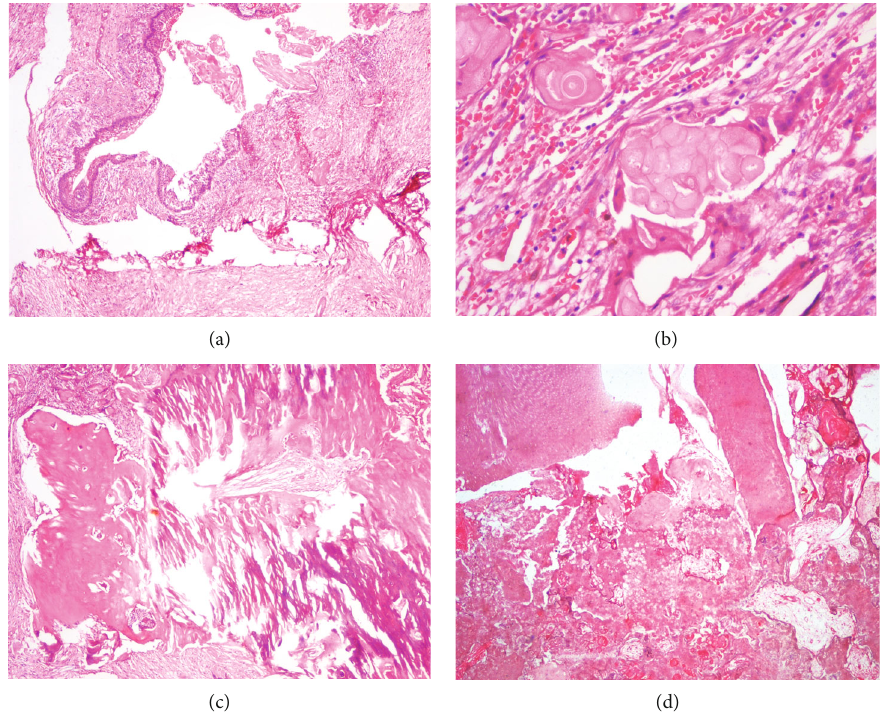
Figure 3: (a) Thick cystic tumor wall, showing loose mature connective tissue. Cystic epithelium is of variable thickness ranging from 10 to 15 cells. The basal cells exhibit reversal of polarity and super fi cial cells show spongiosis (H&E stain, × 40). (b) Ghost cells are seen in small and large clusters in the connective tissue along with epithelial cells (H&E stain, × 100). (c) Large amount of dentinoid induction with entrapped ghost cells and calci fi ed ghost cells (H&E stain, × 40). (d) Decalci fi ed section showing dentin, cementum-like tissue, and ectomesenchymal tissue arranged haphazardly with entrapped ghost cells (H&E stain, × 40).